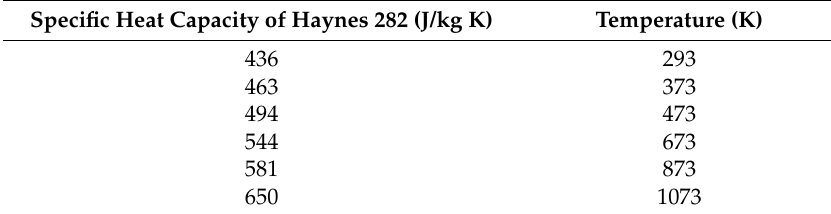
Table 7. Temperature dependence of specific heat capacity [19].